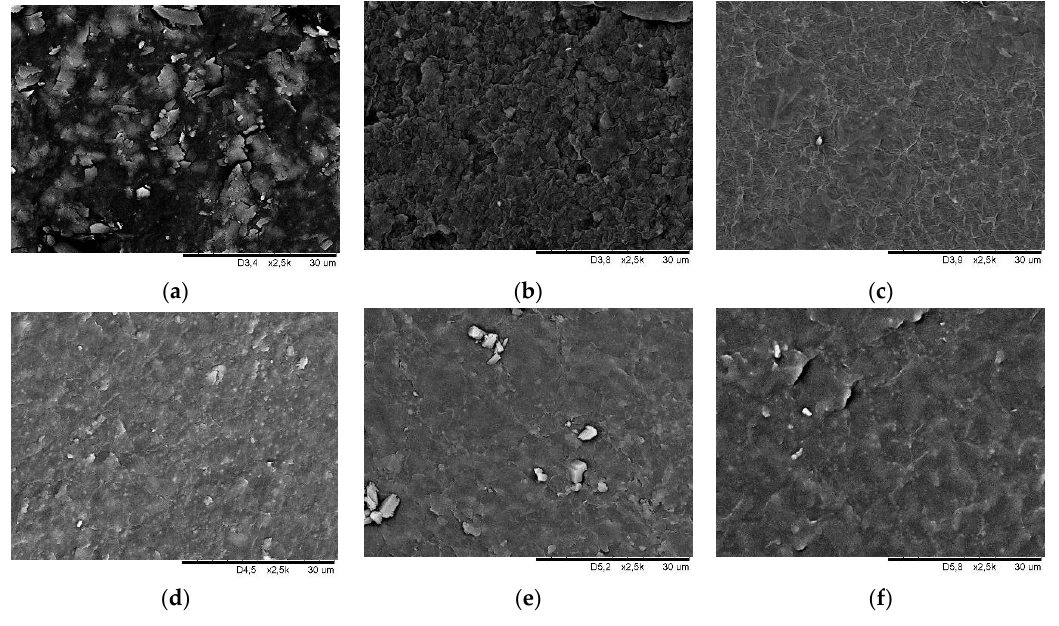
Figure 6. IR spectra of polymer materials made of butyl rubber (SC — chemically modified smooth samples, GC — chemically modified geometrised samples subjected to plasma modification in the air (PP) or argon (PA), and for non-modified polymer material made of butyl rubber).